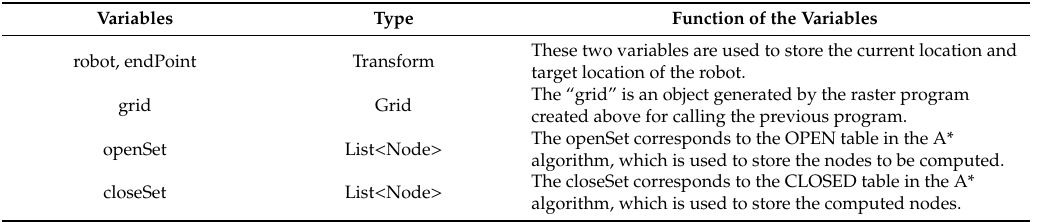
Table 8. Definition of data members of the Findpath